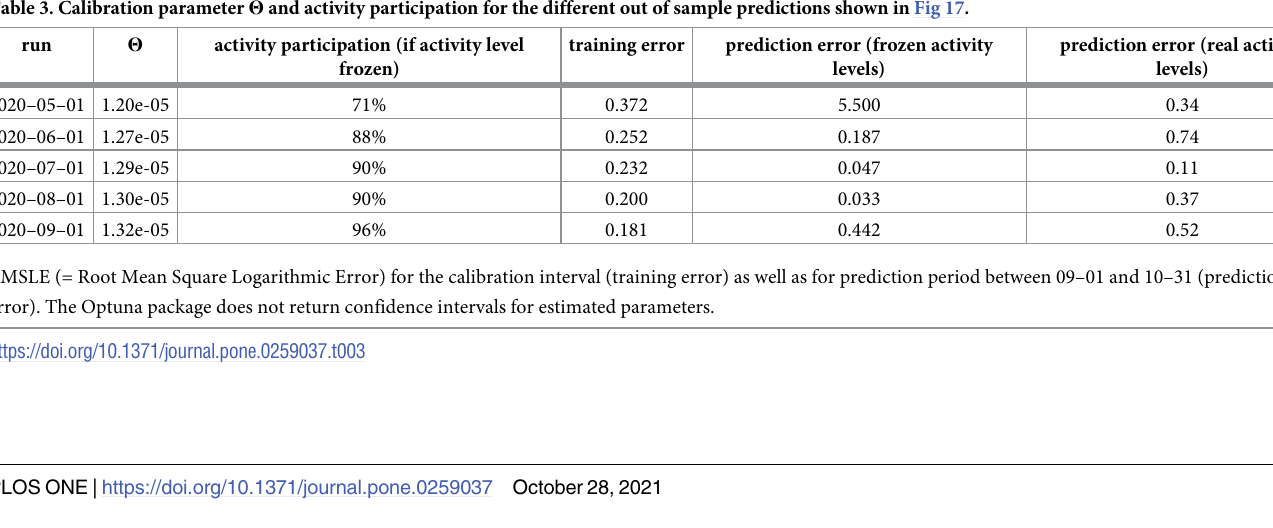
Table 3. Calibration parameter Θ and activity participation for the different out of sample predictions shown in Fig 17. run Θ activity participation (if activity level frozen)